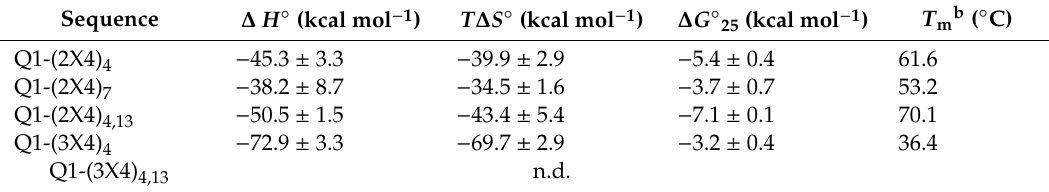
Figure 2. Normalized UV melting curves for ( a ) Q1 (black), Q1-(X4) 4 (green), Q1-(2X4) 4 (red), and Q1-(3X4) 4 (blue) and ( b ) Q1 (black), Q1-(X4) 4,13 (green), Q1-(2X4) 4,13 (red), and Q1-(3X4) 4,13 (blue). The bu ff er contained 100 mM KCl, 10 mM K 2 HPO 4 (pH 7.5 at 25 ◦ C), and 1 mM K 2 EDTA. The strand concentration was 3 µ M. Table 2. Thermodynamic parameters of G-quadruplex formation with branched TEGs a